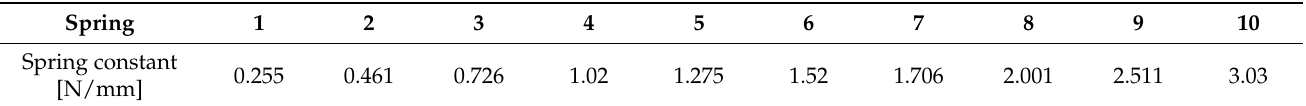
Table 3. Spring constant for tested